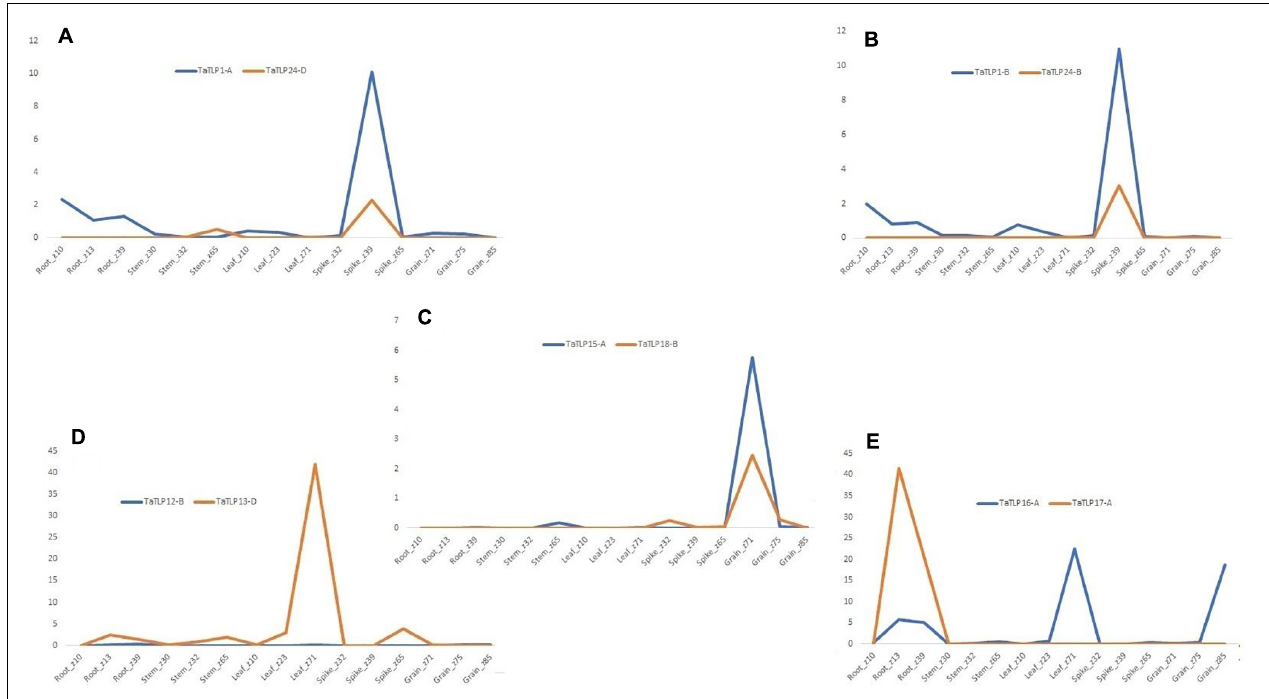
FIGURE 8 | Comparative expression analysis of duplicated gene pairs in T. aestivum . (A–E) Represent the comparative expression pattern of paralogous TaTLPs under various tissue and developmental stages. Based on their expression trend, TaTLPs are categorized into the retention of function (A–C) and pseudo functionalization types (D,E)